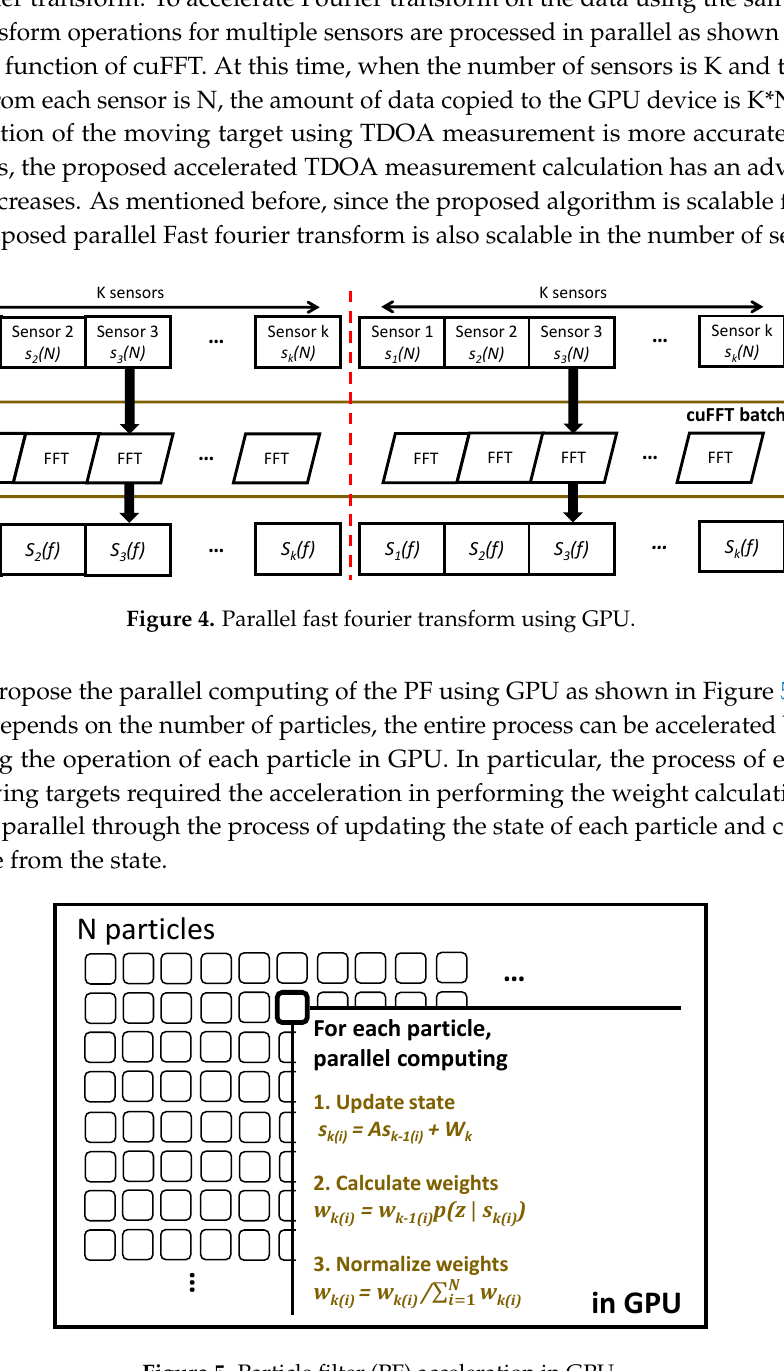
Figure 5. Particle filter (PF) acceleration in